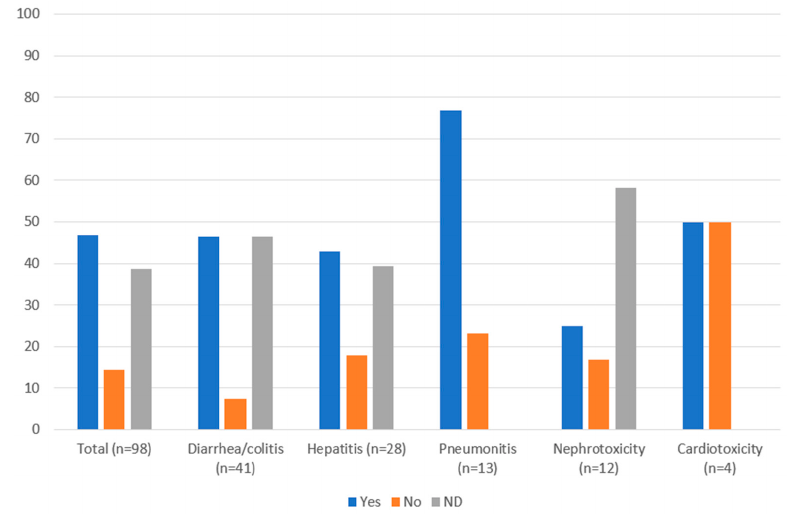
Figure 3. Guideline adherence for management of immune-related adverse events (%) in patients with cancer receiving nivolumab, ipilimumab, or nivolumab plus ipilimumab in Nova Scotia Health-Central Zone, by organ system. ND: not documented.